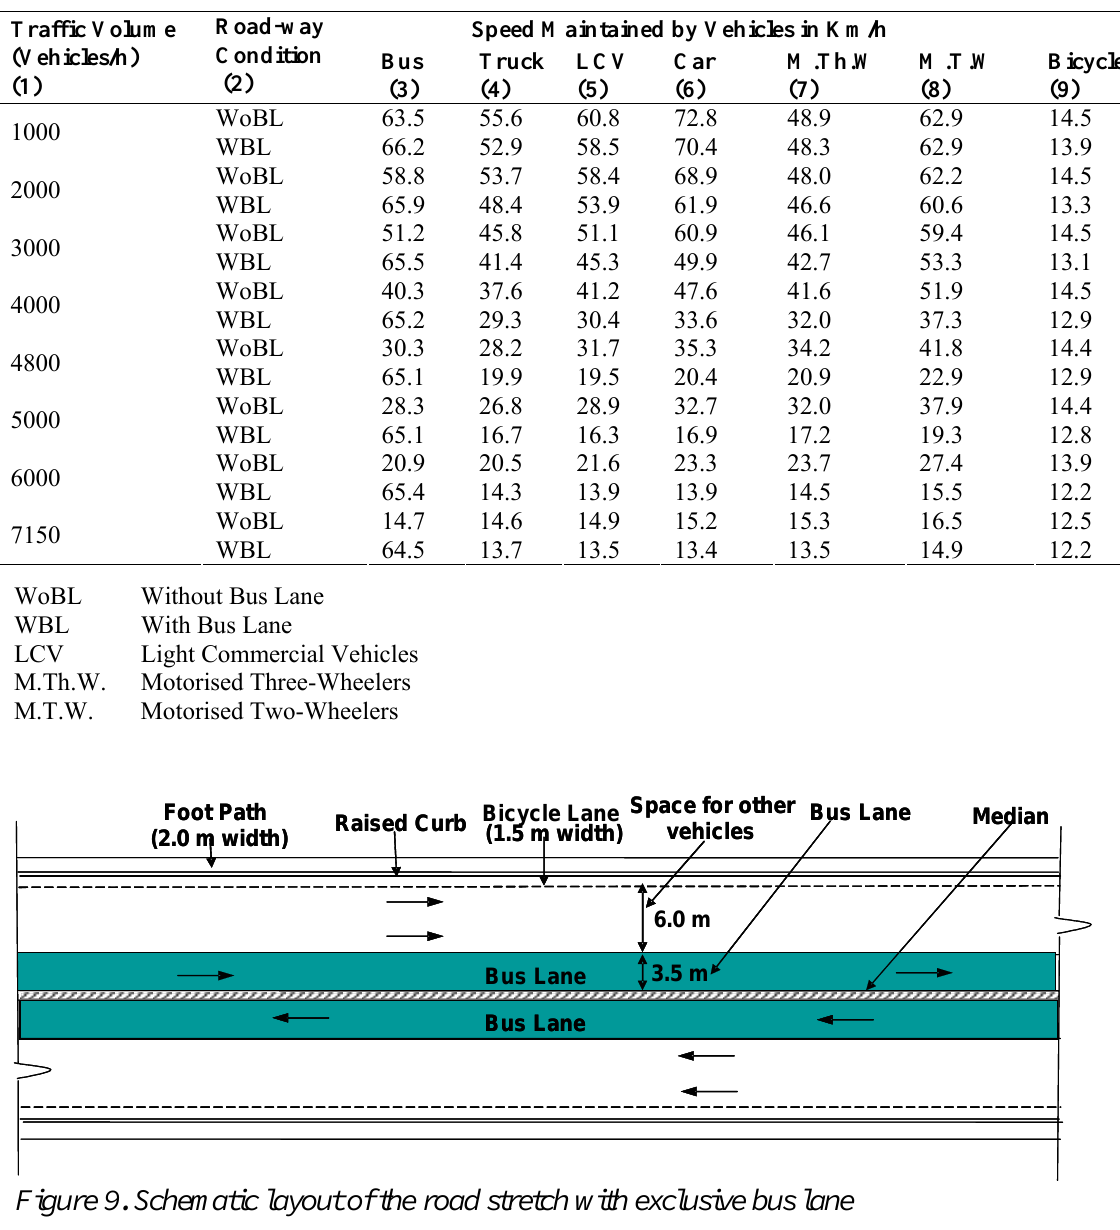
Table 3. Speeds of different categories of vehicles on the roadway with and without bus lanes